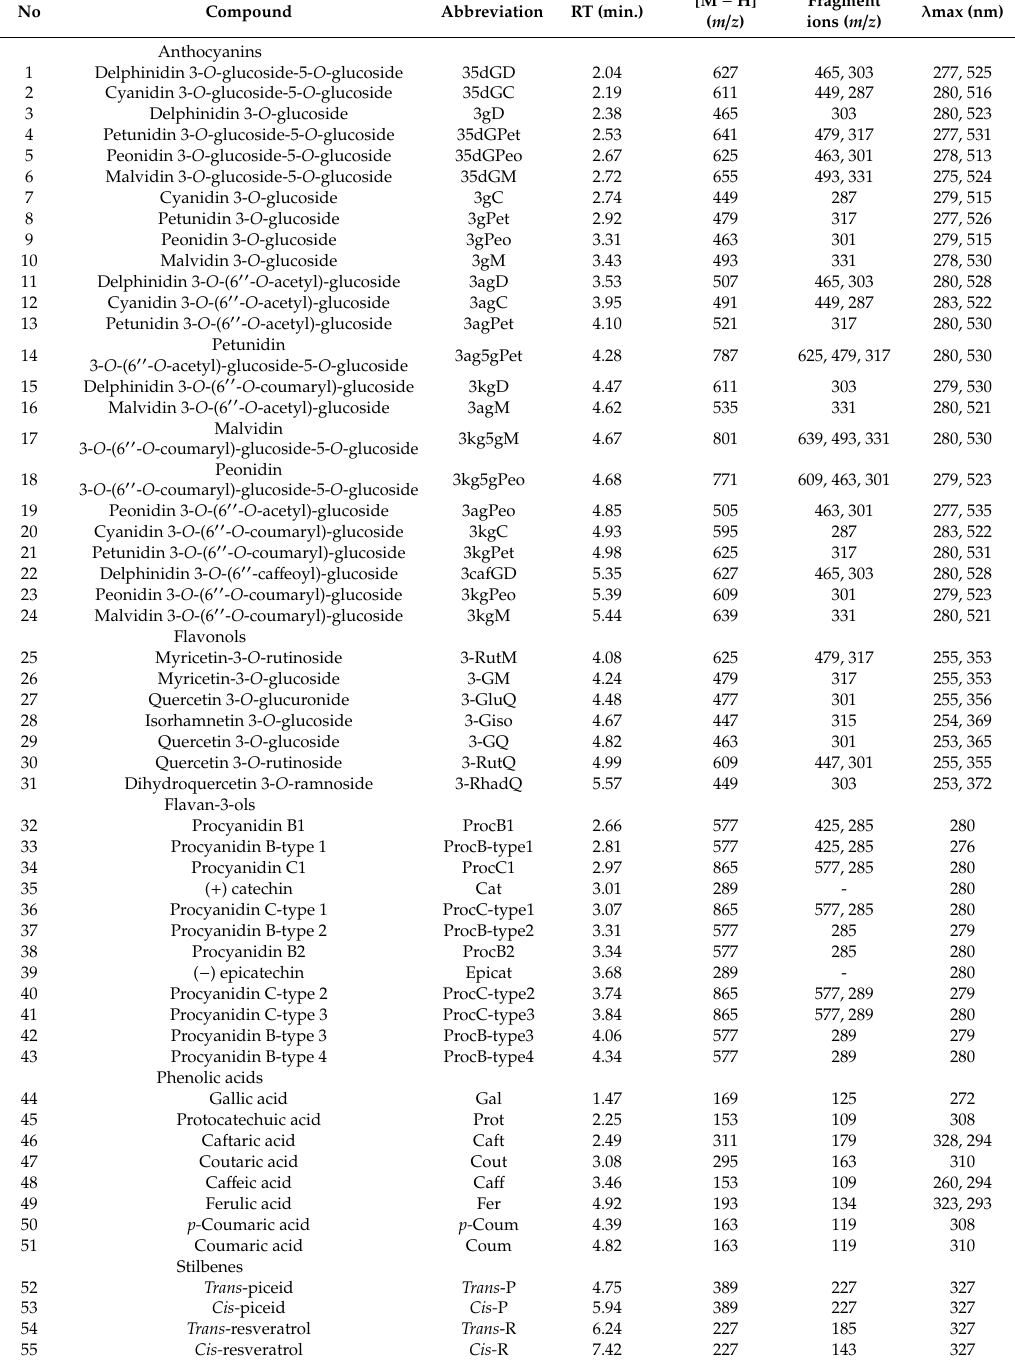
Table 1. UPLC-PDA-MS / MS identification parameters of phenolic